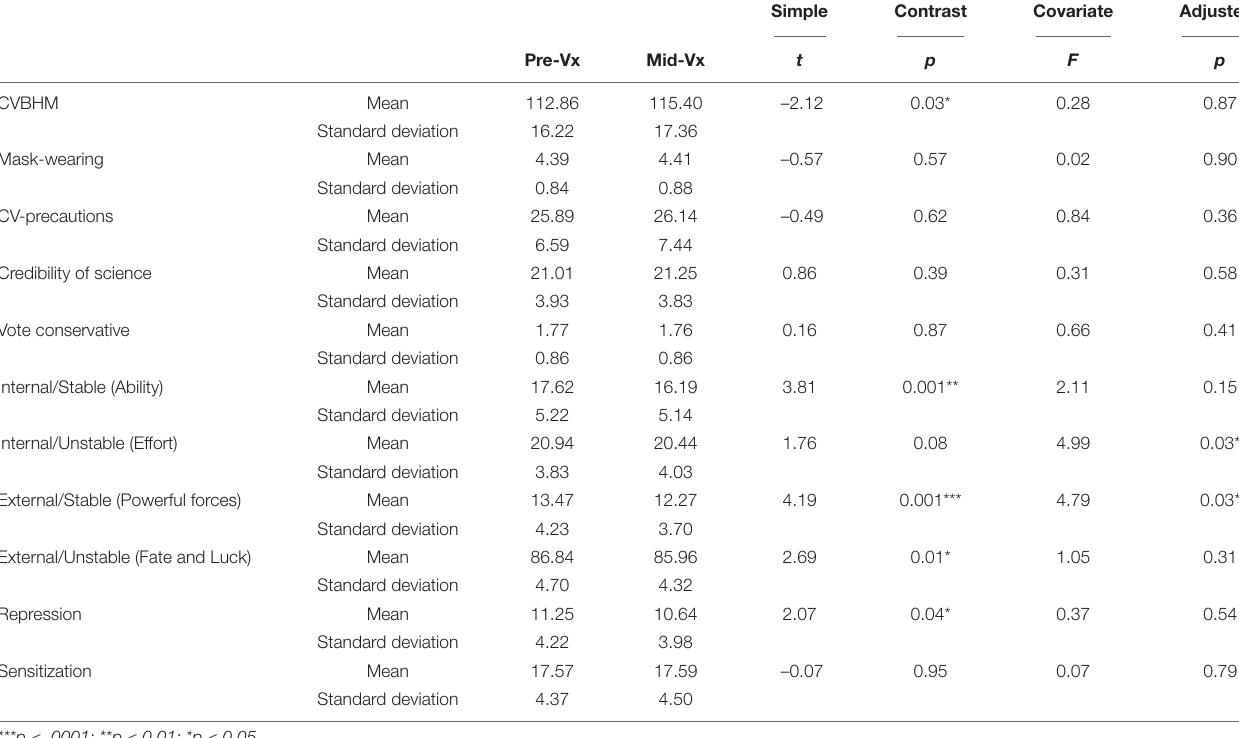
TABLE 3 | Psychological differences between Pre-Vx and Mid-Vx Samples, with and without covariates (Study 1).